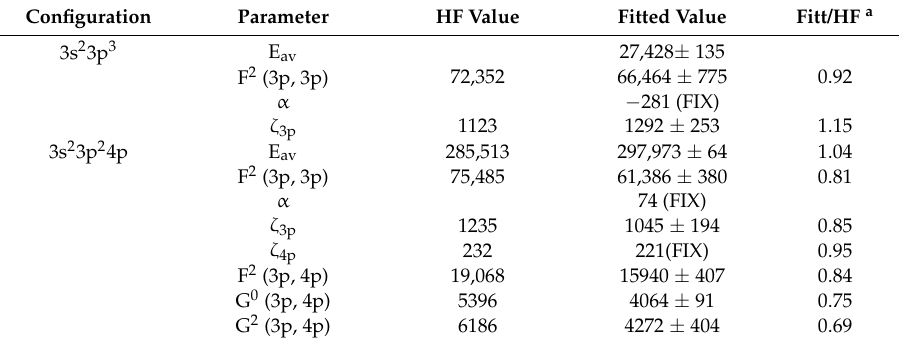
Table 7. Energy parameters (cm − 1 ) for the studied odd parity configurations of Ar IV.